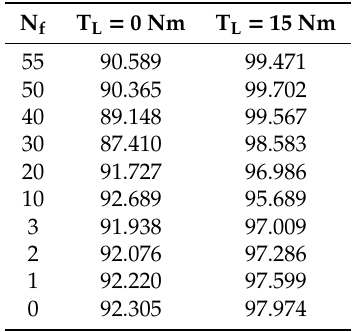
Figure 6. Torque waveforms of a faulty (N f = 1 – 50) as well as a healthy (N f = 0) motor at rated torque (T L = 15 Nm).